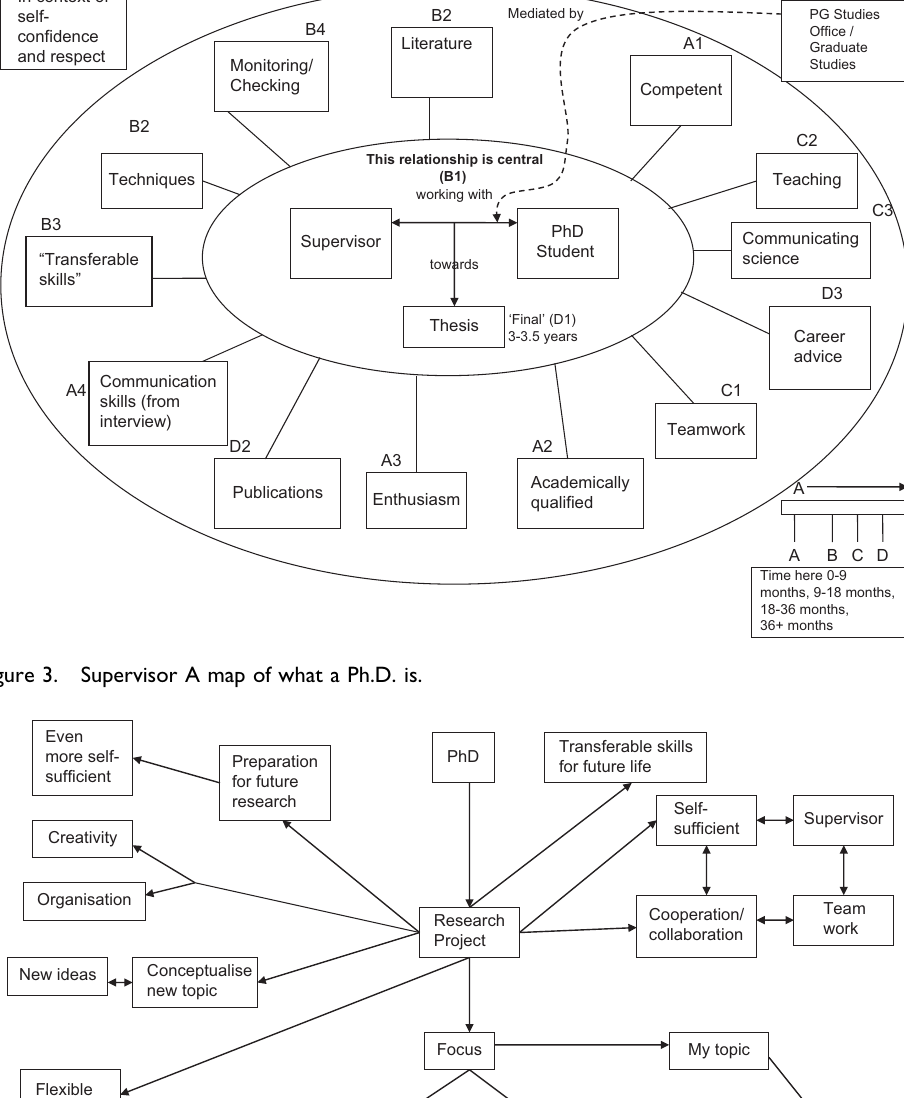
Figure 4. Initial student map of what a Ph.D. is.